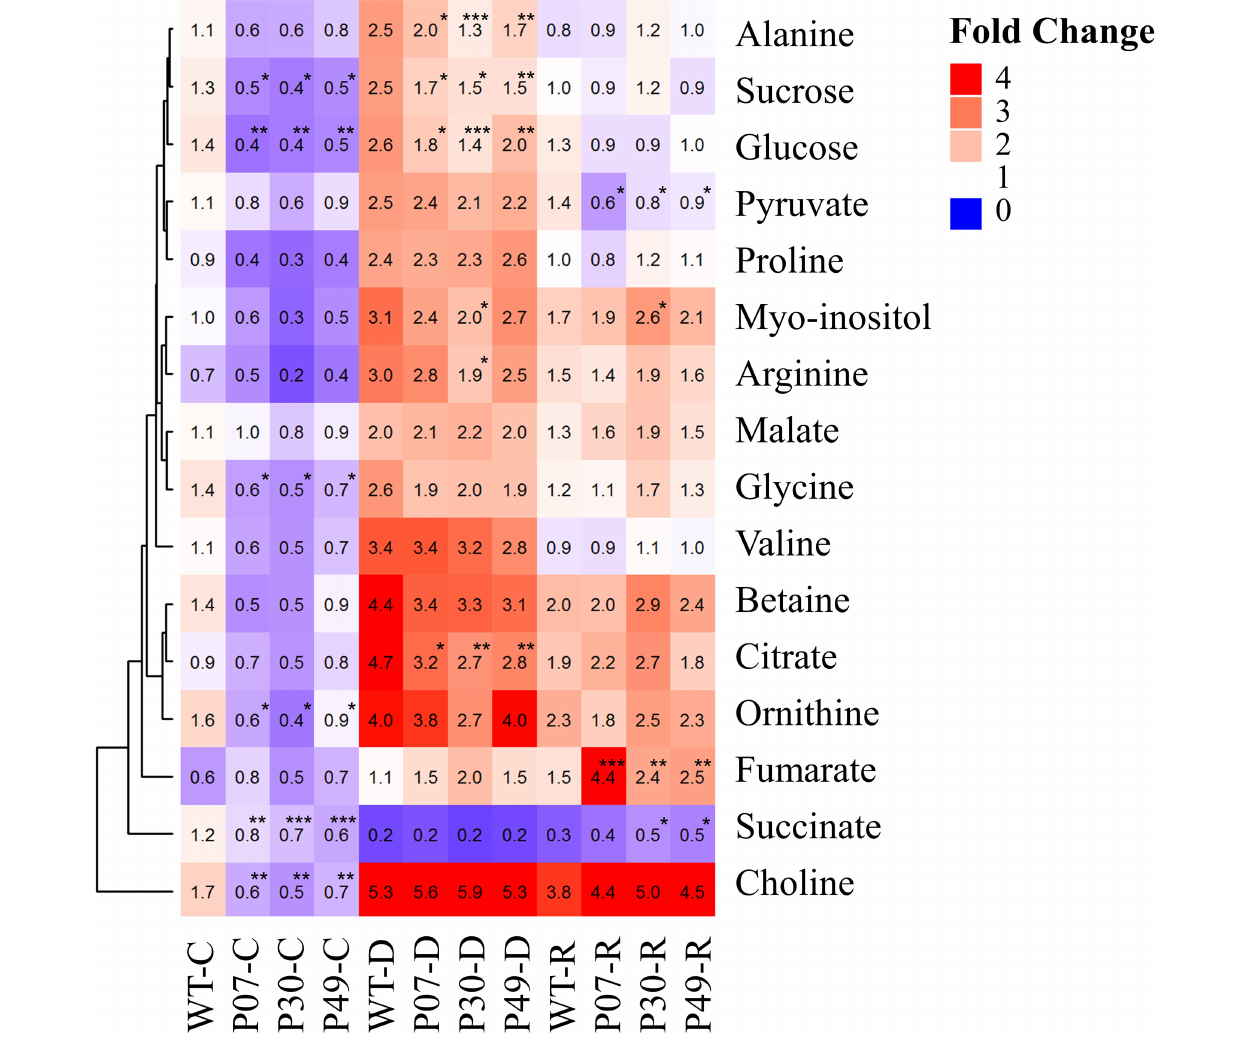
FIGURE 9 | Heatmap showing the distribution of metabolites that were significantly affected by drought stress. Metabolites were isolated from WT and transgenic plants (P07, P30, and P49) under well-watered (C), drought (D), and recovery (R) conditions for metabolomics using H¹-NMR. The average fold-change is displayed inside the enclosed cells as relative to those of WT under control conditions. Cells represent the means of 5 plants ± SD. Points with *, **, and *** mean that the transgenic line differ significantly from the WT ( P < 0.1, P < 0.05, and P < 0.01,